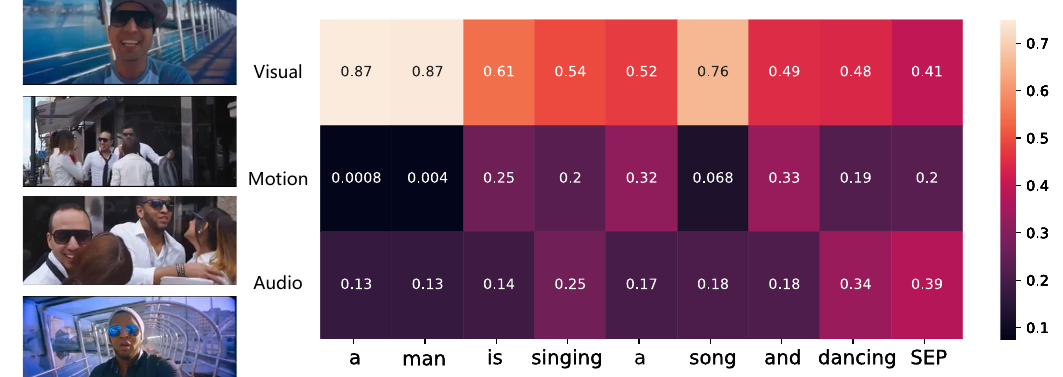
Figure 7. Visualization of attention weights of the last layer of caption generator. Each row represents a modality, and each column represents the attention weights of three modalities when generating a word. SEP is the end symbol. The example video is a music video of a pop song from MSR- VTT